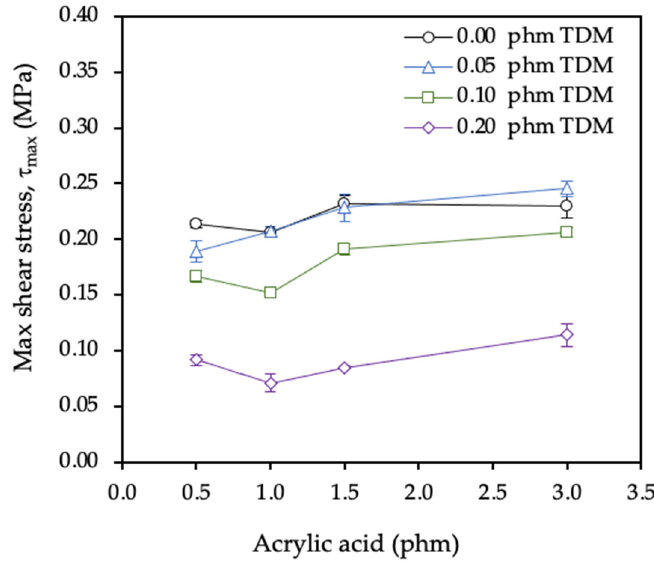
Figure 10. E ff ect of acrylic acid and tert-dodecyl mercaptan (TDM) on the shear strength of the adhesive.